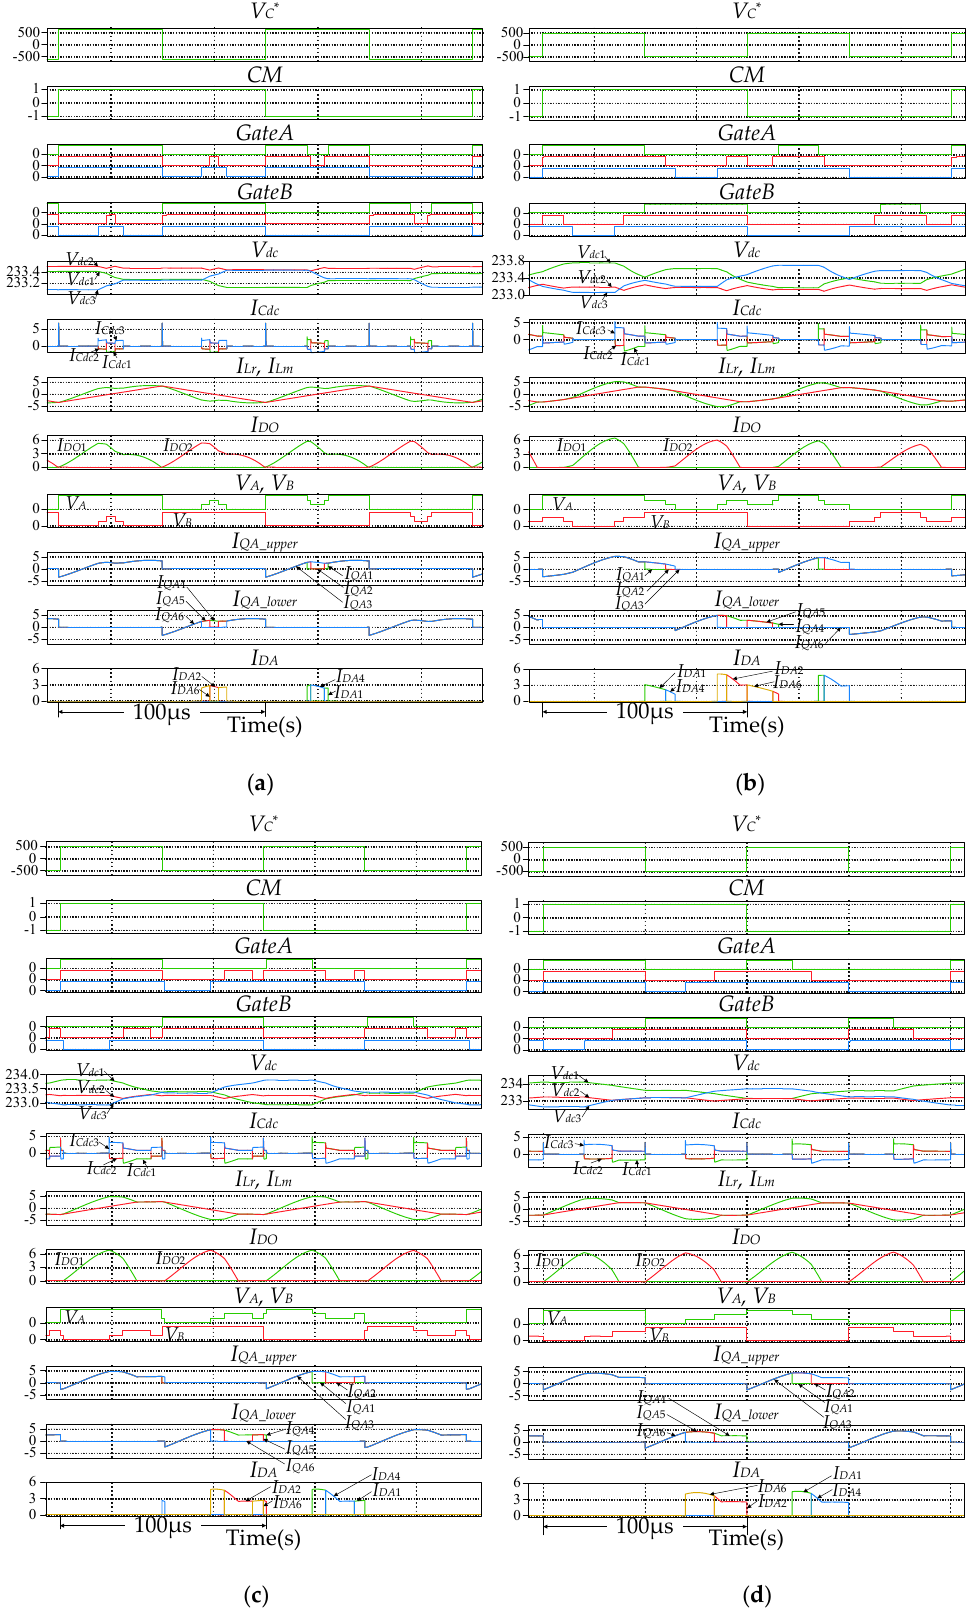
Figure 16. Simulation results for the ( a ) middle, ( b ) edge, ( c ) rear, and ( d ) end sags.